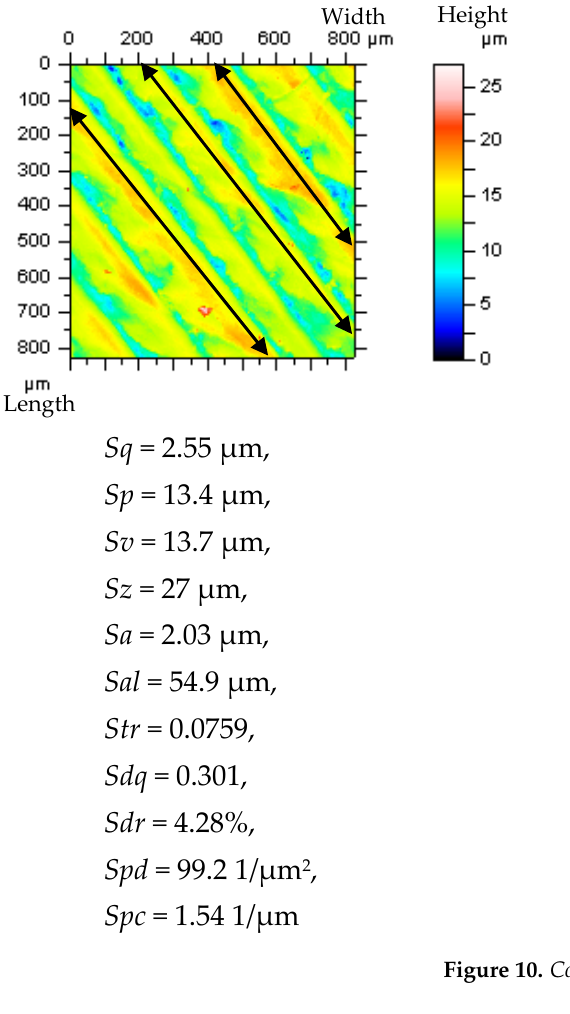
Figure 9. Ground detail measured by a stylus instrument at the speed of 1 mm/s ( a ), and its NS defined by FFTF (cut–off = 0.025 mm) ( b ) with the texture after the HFN denoising ( c ), thresholded (0.13%–99.87%) NS ( d ), ACF of NS ( e ) and thresholded ACF of NS received by the FFTF method ( f ); all figures are presented in contour map plots.